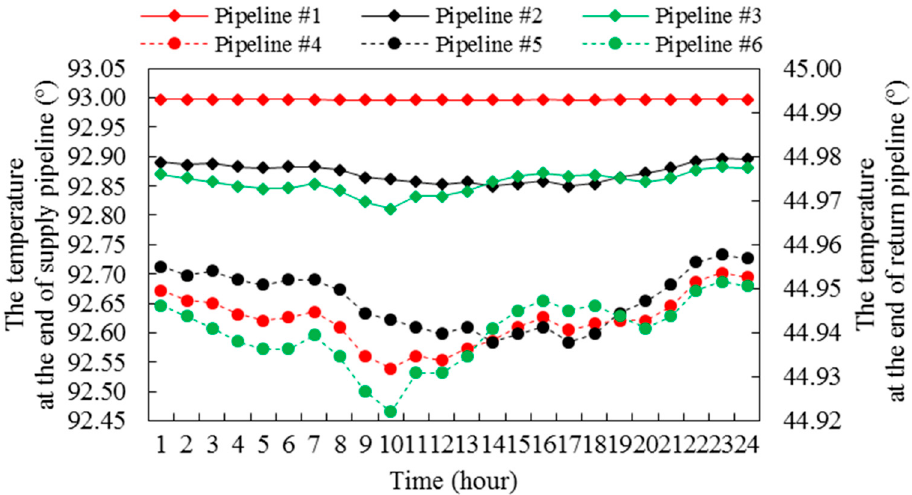
Figure 10. Change in the pipeline’s temperature in the district heating system.